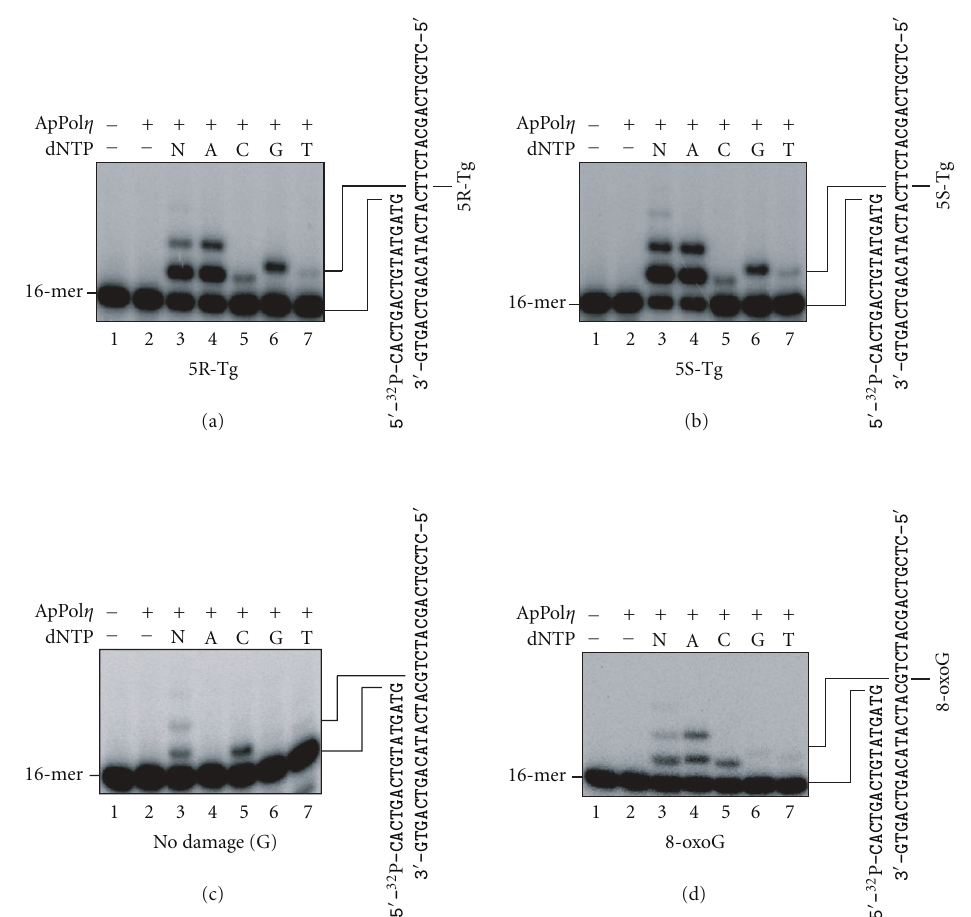
Figure 6: Selectivity of nucleotide incorporation by ApPol η opposite 5 R -Tg (a), 5 S -Tg (b), undamaged G (c), and 8-oxoG (d). ApPol η (12 fmol in lanes 2–7) was incubated with each primer-template in the presence of the four dNTPs (lane 3), the indicated dNTP (lanes 4–7), or the absence of dNTP (lane 2). Lane 1 contained no enzyme. The reactions were incubated at 37 ◦ C for 5 minutes, and then were subjected to 15% polyacrylamide/7.5 M urea gel electrophoresis. The autoradiograms of the gels are